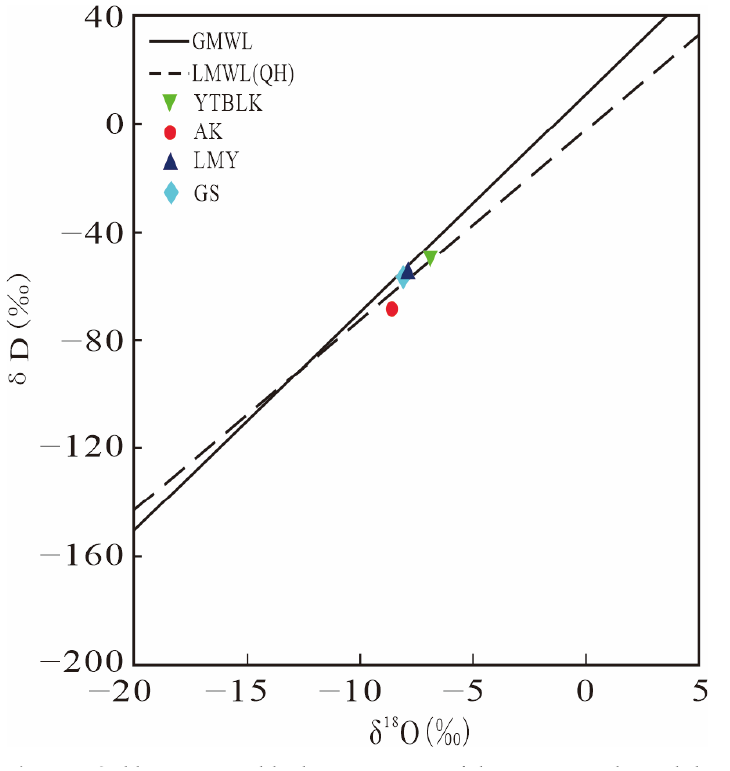
Figure 5. Stable oxygen and hydrogen isotopes of the water samples and their correlations with GMWL and LMWL.